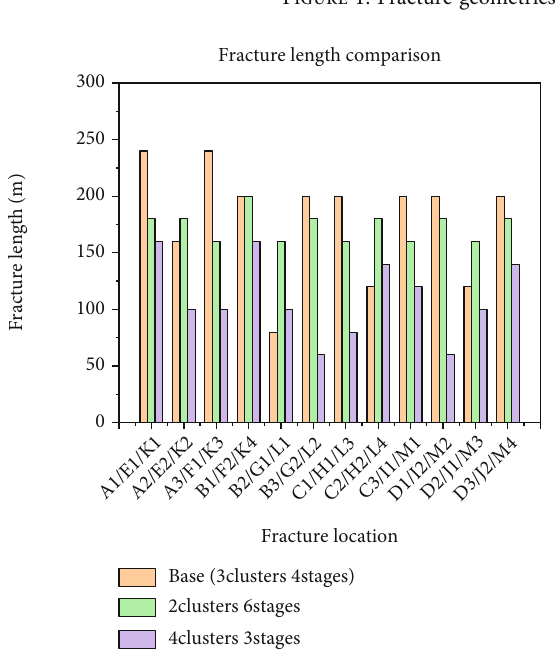
Figure 2: Comparison of fracture length for scenarios with di ff erent stage and cluster